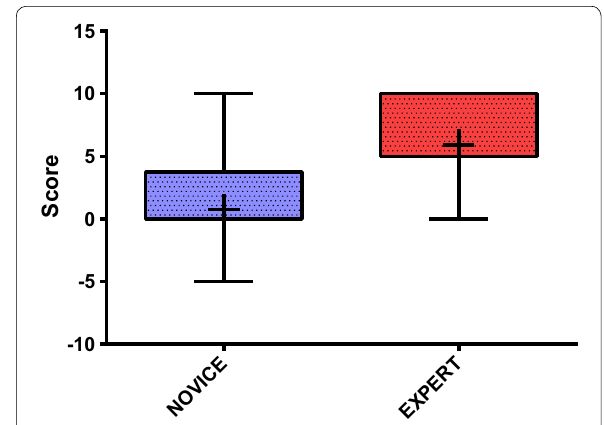
Fig. 3 Performance rating score for the Novice and Expert groups. The colored boxes extend from the 25th to 75th percentiles. The whiskers indicate the minimum and maximum values. The plus signs indicate the mean value. p 0.0026 =